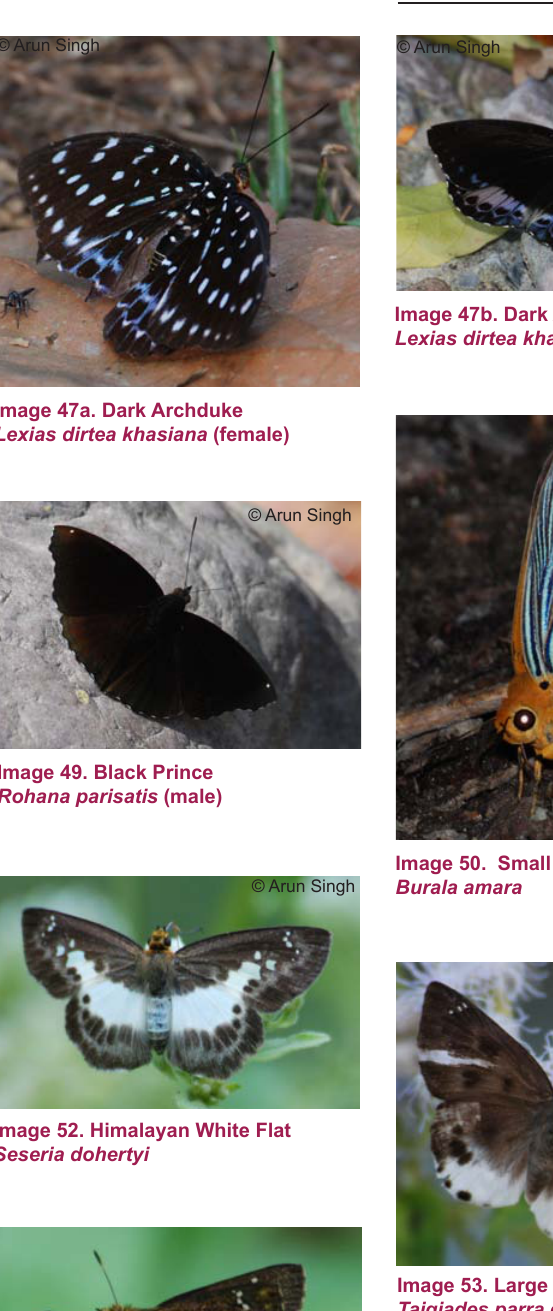
Image 53. Large Snow Flat Taigiades parra gala